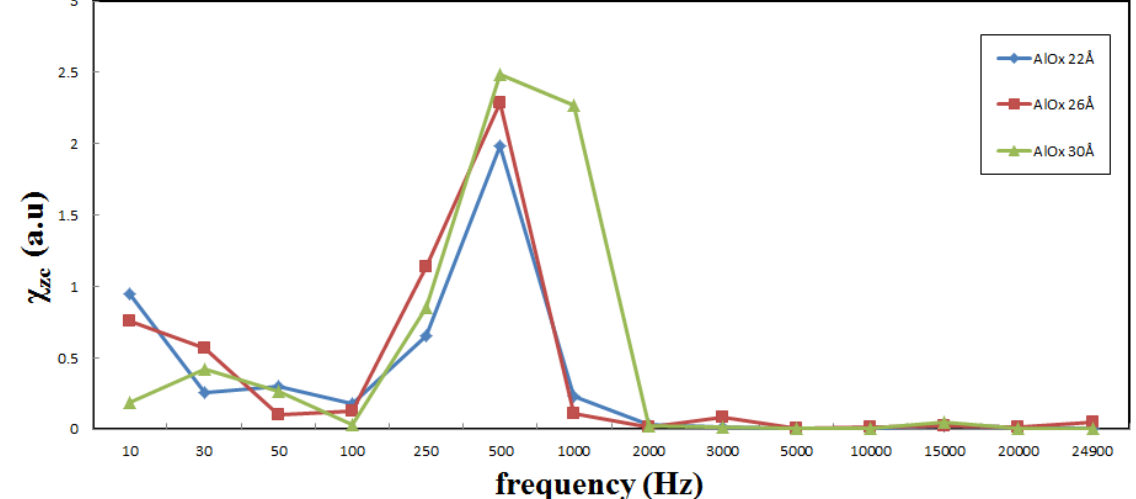
Figure 4. Susceptibility ( χ of frequency, 10–25,000